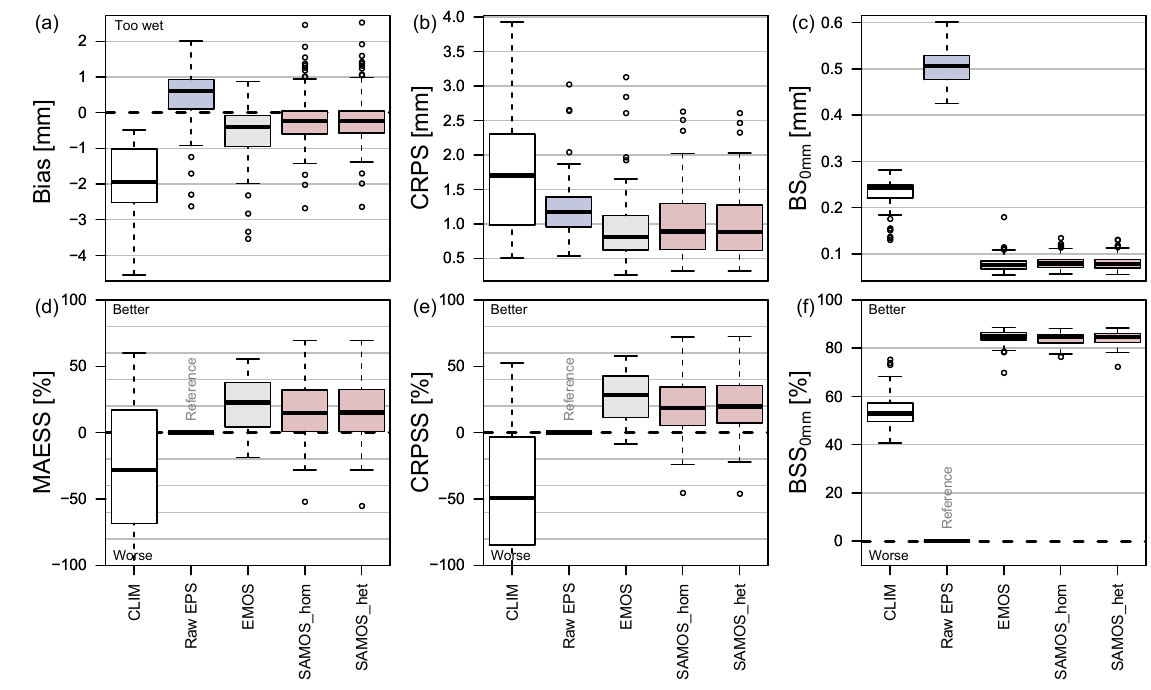
Figure 3. Scores for 24h precipitation sums based on the full predictive distribution for + 30, + 54, and + 78h forecasts as used for model training. Box-and-whiskers of station-wise mean scores for (a) bias (observation minus forecast), (b) CRPS, and (c) Brier scores for proba- bility of precipitation. The scores are shown for the climatology (CLIM), raw EPS, and the three postprocessing models (cf. Table 1). The lower row shows skill scores for (d) mean absolute error, (e) CRPS, and (f) Brier score for probability of precipitation with the raw EPS as reference. Positive skill scores indicate an improvement over the raw EPS